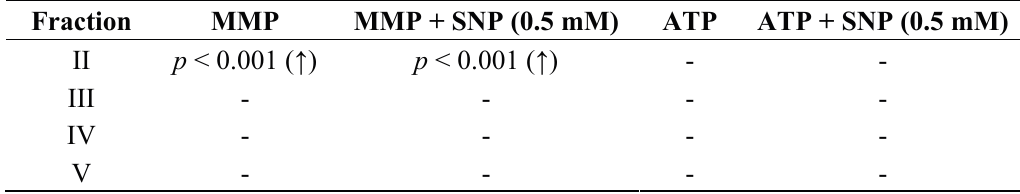
Table 3. Basal mitochondrial membrane potential (MMP) and ATP concentrations of PC12 cells after 25-h incubation (MMP) or 7-h incubation (ATP) with fractions extracted from hexanic rice bran extract (RBE),0.3 mg/mL) as well as MMP and ATP concentrations of PC12 cells after preincubation with fractions for 1 h and subsequent insult with SNP (0.5 mM) for 6 h (ATP) or 24 h (MMP); n = 4–5; ANOVA with Tukey’s post -test; ↑ indicates increased MMP or ATP; -: no significant effect could be